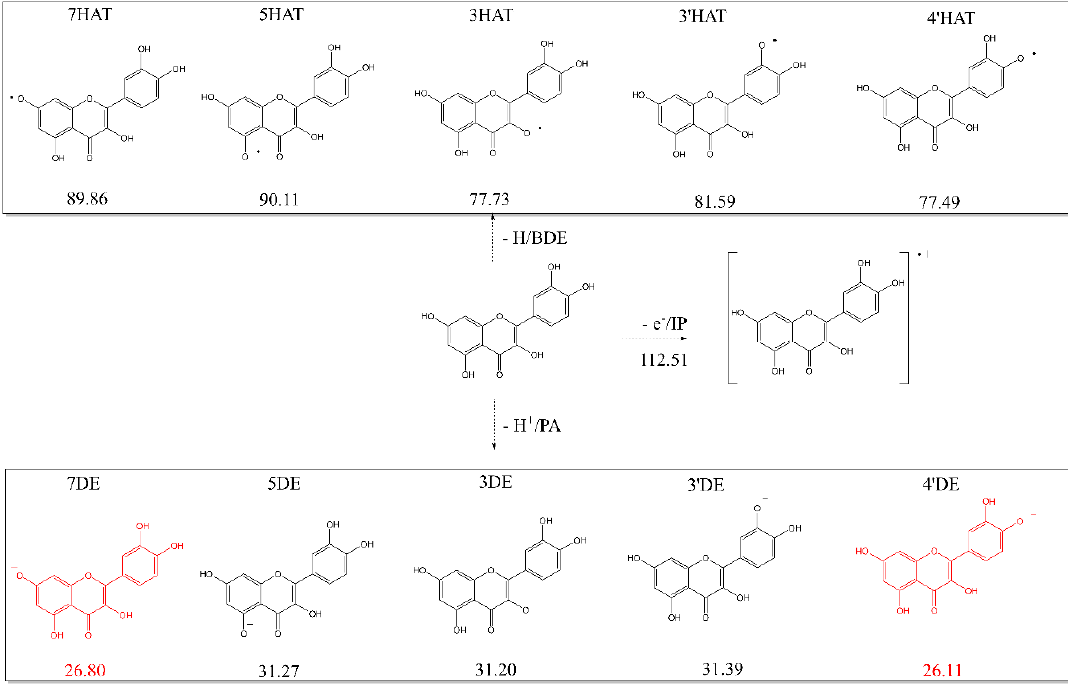
Figure 1. The products formed out of Q by hydrogen atom transfer, electron transfer or proton transfer; and the BDE, IP or PA enthalpies (in Kcal / mol) for the formation of these products. The two products in red are the products formed out of Q by deprotonation (proton transfer) of its 7-OH or 4 ′ - OH group, and the formation of these products appeared to require the lowest reaction enthalpy.